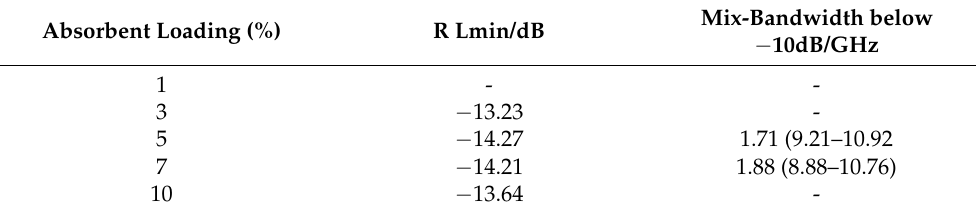
Figure 7. Influence of the absorbing agent level on the reflectivity of the coating. Table 5. Absorption properties of the